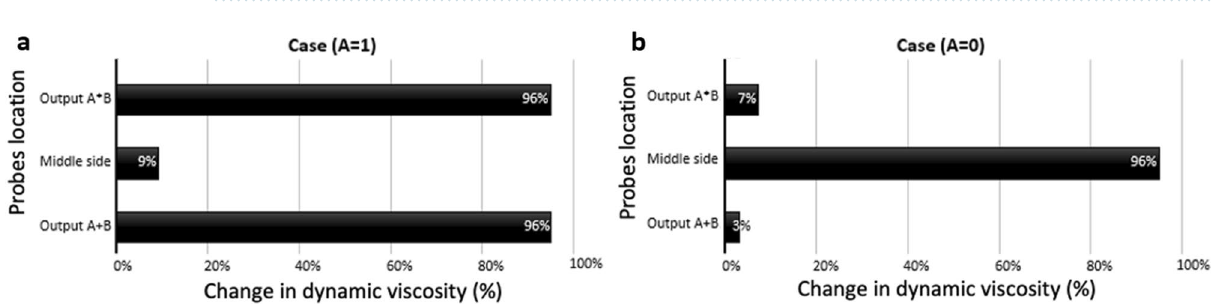
Figure 7. The percentage change of dynamic viscosity for the three selected points at the outlets in the fluidic network: 1. Output D 1 , 2. Output A , and 3. Output D 2 . ( a ) The case A = 0 , ( b ) The case A = 1 . In the case of A = 0 , where bubbles reach output A , the percentage change of dynamic viscosity is almost 100%. In contrast, in the case A = 1 , the percentage change of dynamic viscosity in A branch is almost